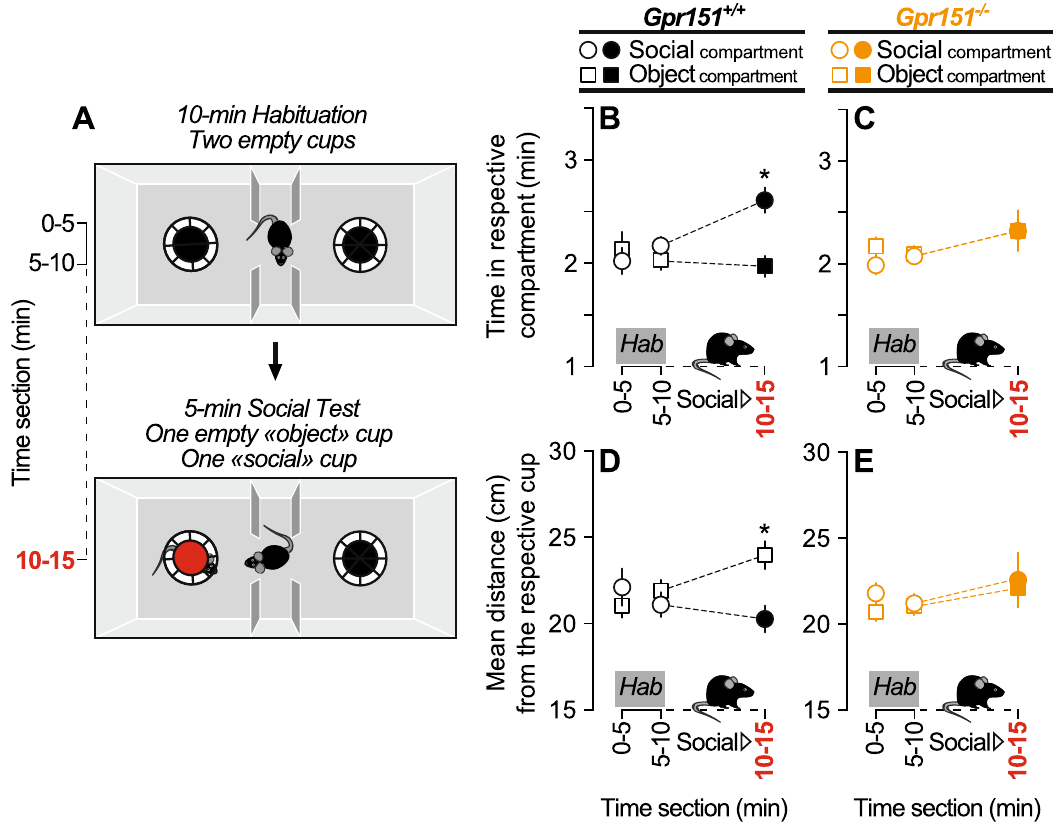
Figure 5. Gpr151 −/− mice do not express social preference in the three-chamber social preference test. ( A ) Schematic representation of the social preference test. ( B,C ) Time spent in the social versus object compartment in Gpr151 + / + and Gpr151 −/− mice, respectively. ( D,E ) Distance from the social versus object cup in Gpr151 + / + and Gpr151 −/− mice, respectively. During the social test, Gpr151 + / + mice spent more time in the social compartment ( B ) and were closer to the social cup ( D ). Gpr151 −/− mice spent a similar amount of time in both compartments ( C ) and were at equidistance from the two cups ( E ). * P ’s < 0.05, object compartment versus social compartment. N’s =